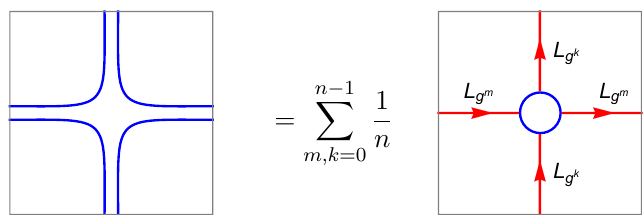
Figure 22 . Fusing an 8-way junction of N (blue) lines into a 4-way intersection of invertible (red)